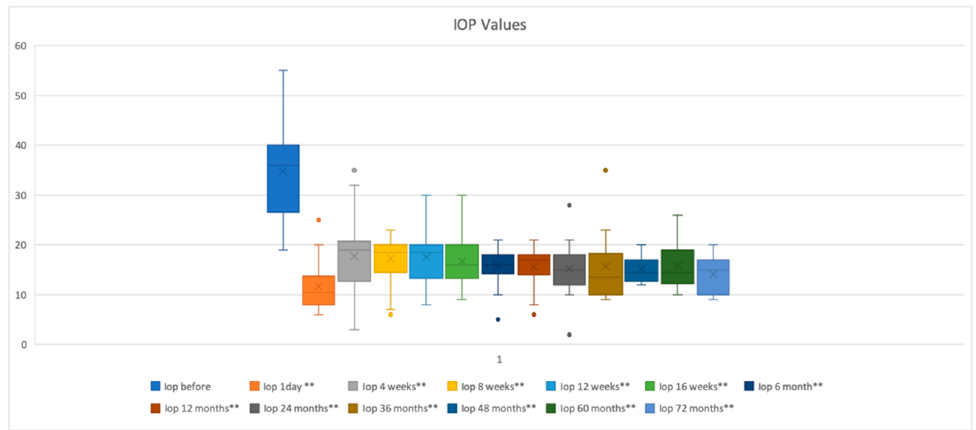
Figure 1. Intraocular pressure (IOP) during follow up. Representation of mean IOP using boxplots for 72 months of follow-up, IOP was significantly reduced at each time point (** p < 0.01). Every time point is represented as the “minimum” and the “maximum” value, the mean value, the median value, and the outliers (color dots) graphically.